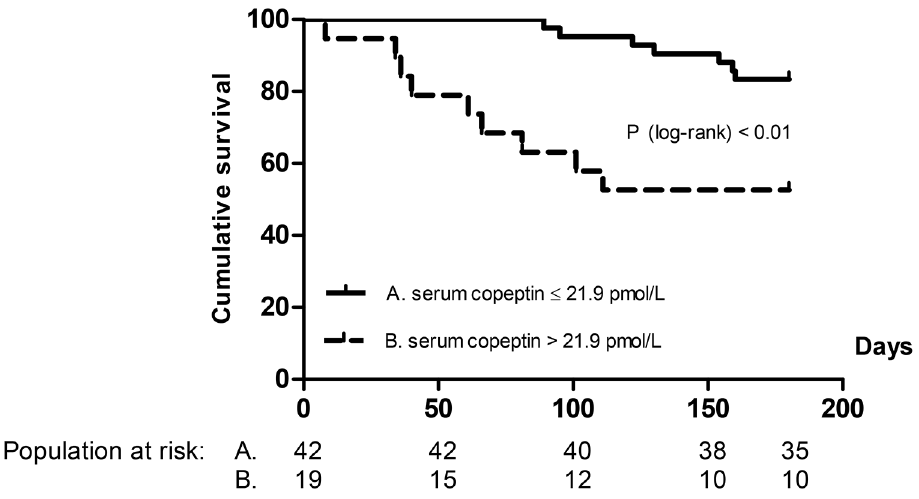
Fig 1. Association of serum copeptin concentration with transplant-free survival. Kaplan Meier survival analysis at 6 months of follow-up of 61 cirrhotic patients registered at the waiting list for liver transplantation, stratified according to serum copeptin concentration (pmol/L) at time of